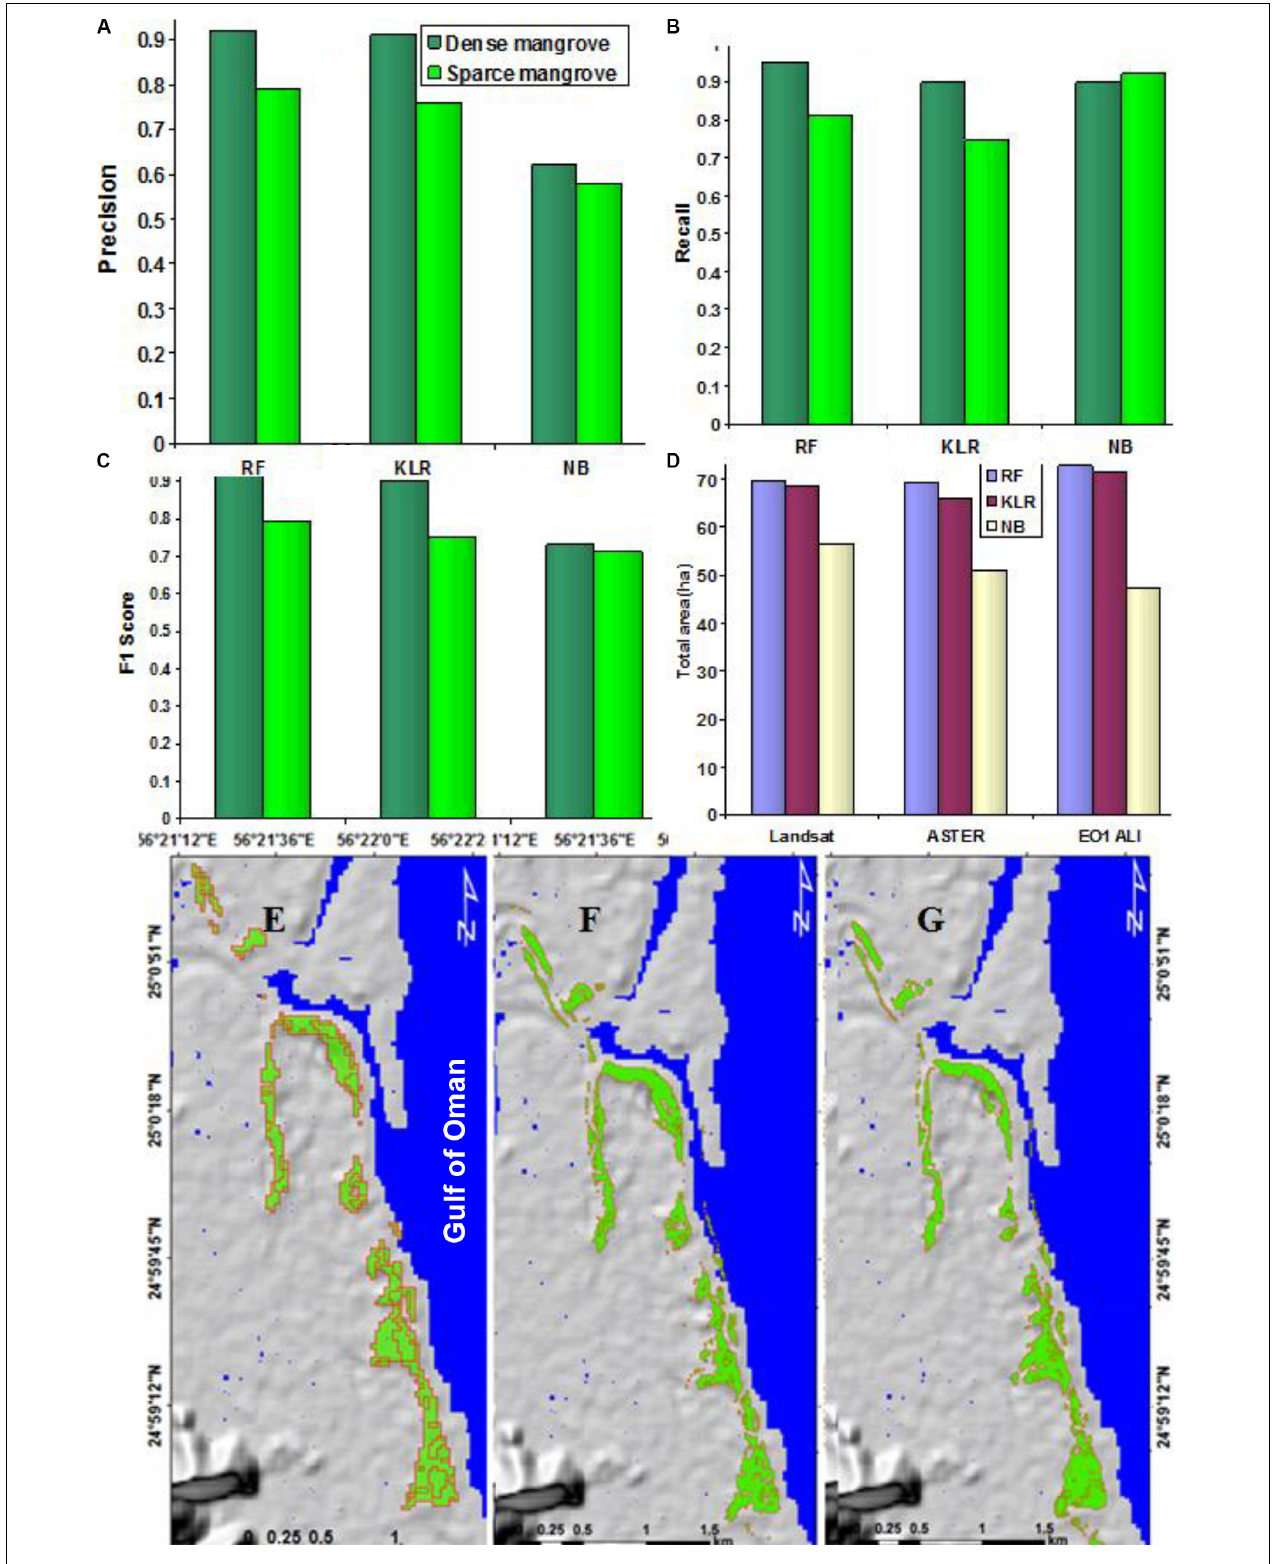
FIGURE 6 | A comparison of the precision (A) , recall (B) , and F1 scores (C) for the Landsat image (August 15, 2019) using RF, KLR, and NB classifiers and total area in ha mapped using RF, KLR, and NB (D) and feature extracted from the Landsat images (E) , ASTER images (F) , and EO-1 (G) for the year 2010.